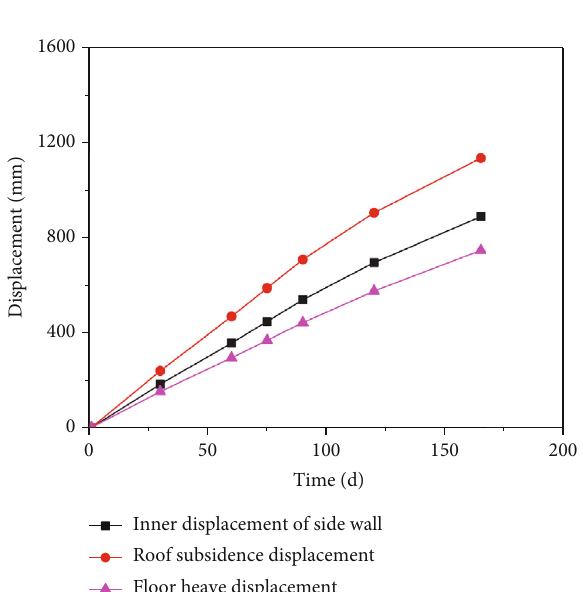
Figure 14: Statistics of roadway